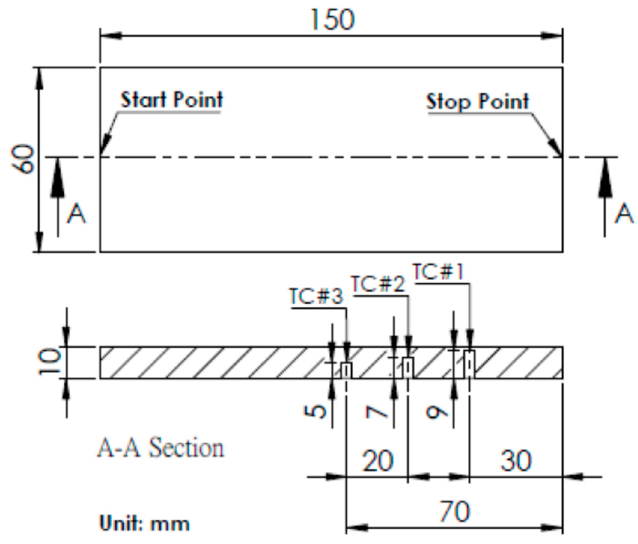
Figure 1. The dimensions of the weldments and the positions of thermal couples (TCs).